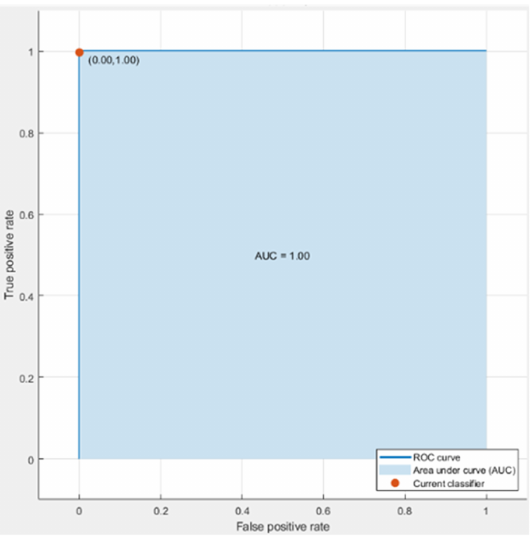
Figure 5. ROC curve of Cubic SVM on non-optimized features.